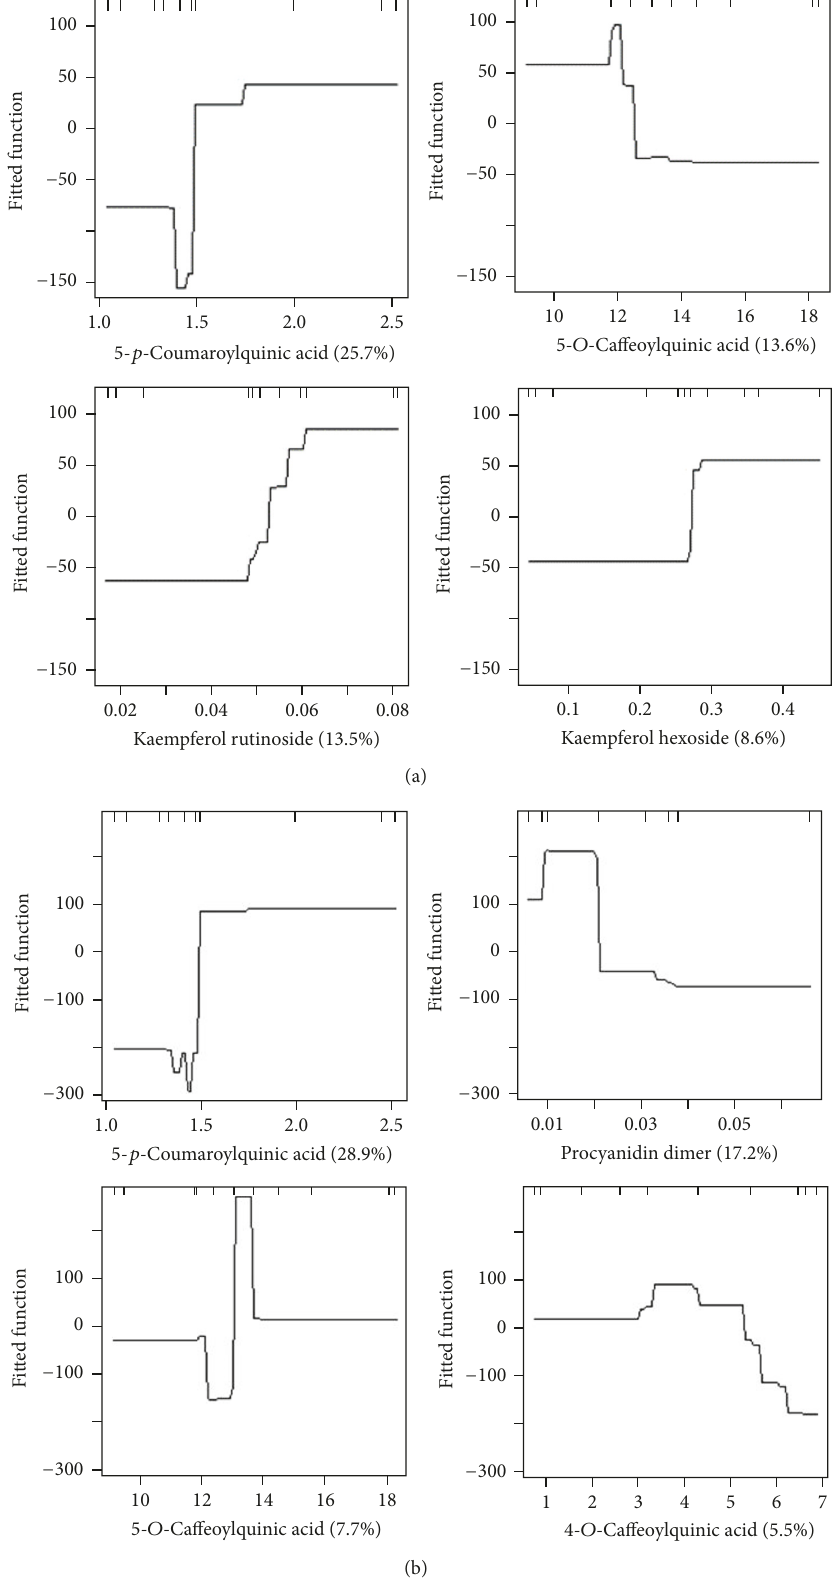
Figure 2: Functions fitted for the Boosted Regression Trees (BRT) model, showing the influence of selected polyphenols (mg/100g) and their contribution (between square brackets) to fit the DPPH (a) and FRAP (b) BRT